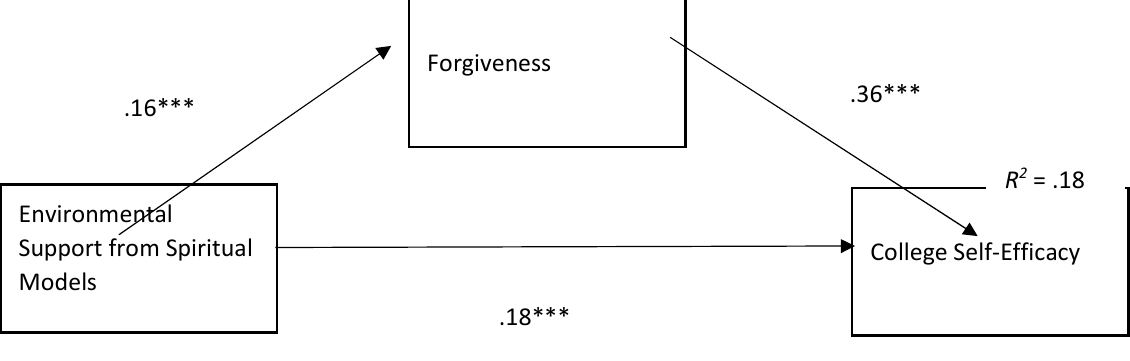
Figure 3. Mediation Path: Forgiveness. Note. *** = p ≤ .001. R 2 =